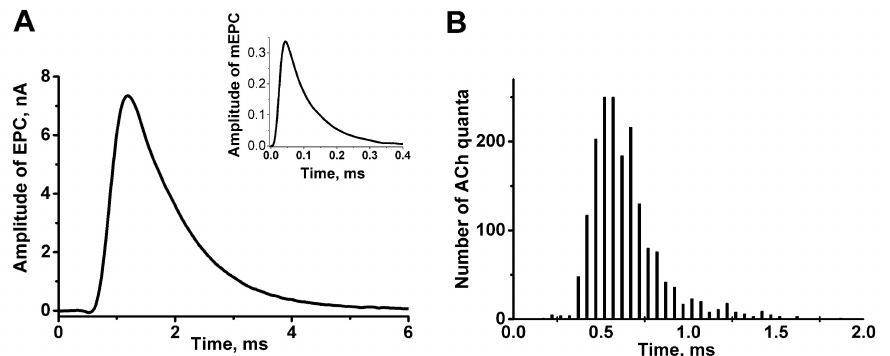
Figure 2. Asynchronous evoked phasic ACh release at extracellular concentration of Ca 2+ close to the physiological level in the frog neuromuscular junction. ( A ) Averaged evoked multiquantal EPC recorded intracellularly under a physiological extracellular Ca 2+ concentration, in the inset—averaged miniature EPC registered in the same neuromuscular junction; ( B ) the distribution of latent periods obtained by the subtraction from 256 multiquantal EPC curve, the average miniature EPC curve registered at the same neuromuscular junction. The ordinate shows the number of latent periods; the abscissa shows time in msec. This figure was based on